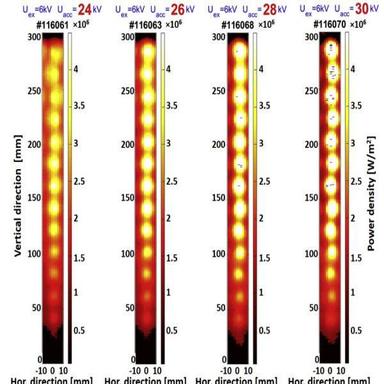
Images from the wire calorimeter showing the central beamlet column for increasing acceleration voltages at a fixed extraction voltage of 6 kV.